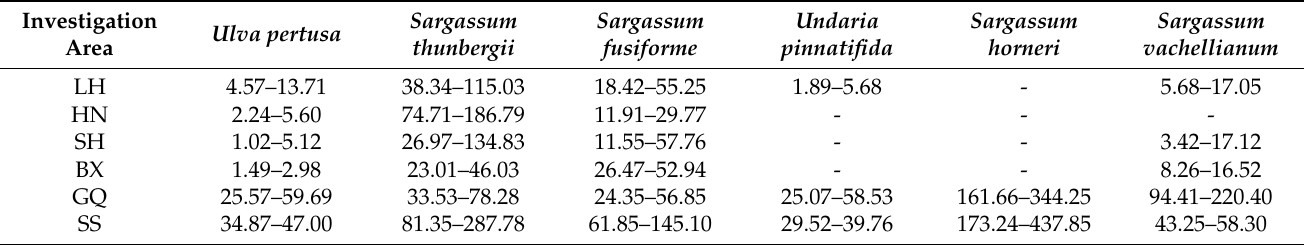
Table 4. Carbon sequestration of seaweed in the Ma’an Archipelago